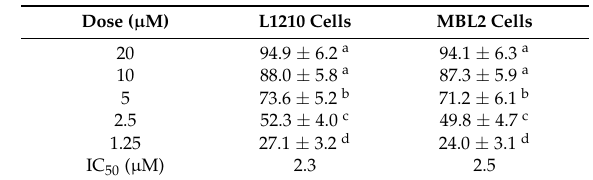
Table 4. Inhibition rate (%) of GBTI on L1210 cells and MBL2 cells.